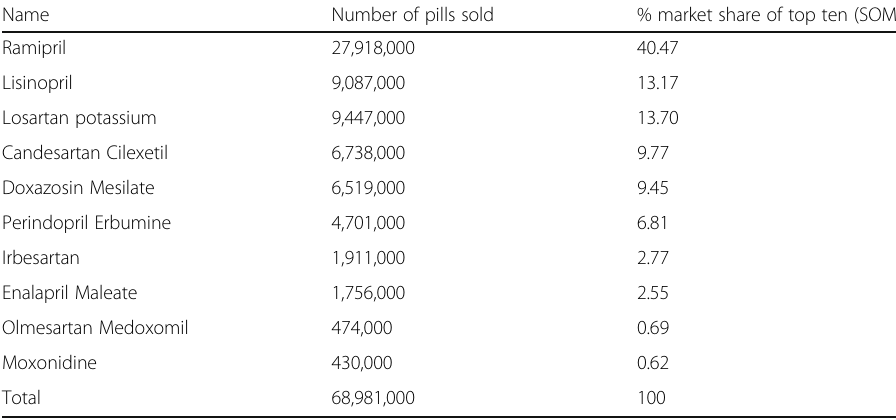
Table 2 Real-world SOM calculations for hypertension based on 2017 top ten UK drug prescriptions for